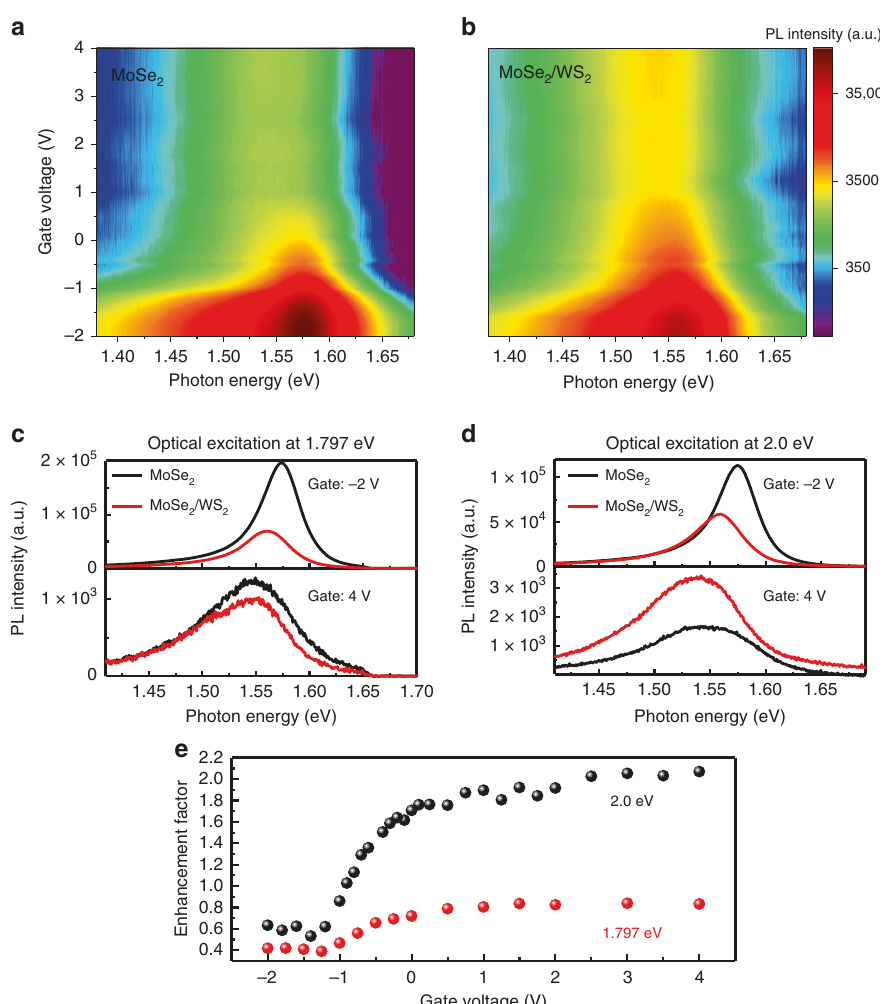
Fig. 2 Gate voltage-tunable transition from PL quenching to PL enhancement in the MoSe 2 /WS 2 heterojunction. a The color plot of the PL spectra for monolayer MoSe 2 and b the color plot of the PL spectra for MoSe 2 /WS 2 heterostructure region as a function of the gate voltage, under the continuous wave (CW) photoexcitation centered at 2.0 eV and with the excitation power of 100 µ W. The color represents the integrated PL intensity at MoSe 2 A exciton resonance. All spectra were taken at room temperature. c , d are PL spectra of the monolayer MoSe 2 (black) and MoSe 2 /WS 2 heterojunction (red) under the CW photoexcitation centered at 1.797 and 2.0 eV, respectively. The excitation power for both c and d is 100 µ W. e The experimentally extracted PL enhancement factor as a function of the gate voltage for the photoexcitation centered at 2.0 eV (black dots) and 1.797 eV (red